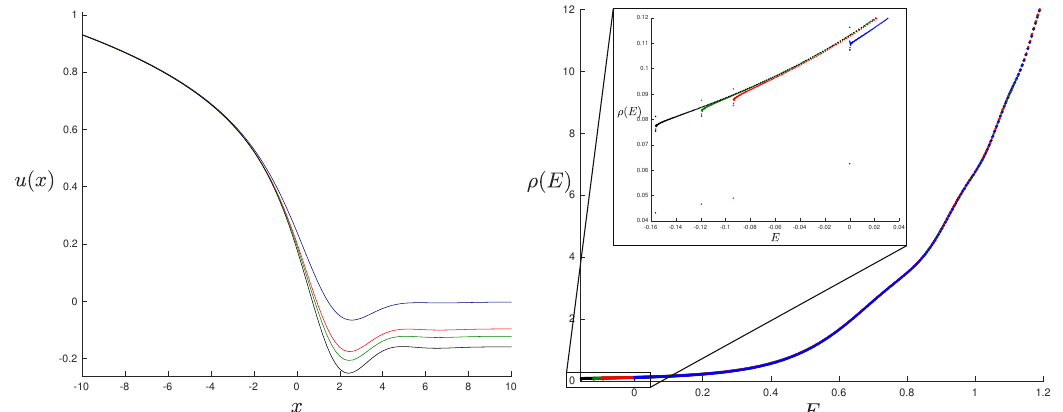
Figure 10. On the left are numerical solutions for the potential u ( x ) obtained by solving the string equation (2.15) for α = 1 / 4 in the k max = 7 truncation and λ = 0 (blue), λ = 0 . 03 (red), λ = 0 . 033199 (green) and λ = 0 . 034798 (black). All of these values are before the zeroth order transition of E 0 that occurs at λ c ’ 0 . 03480 . On the right are the associated spectral densities obtained from (2.6) and plotted using the same